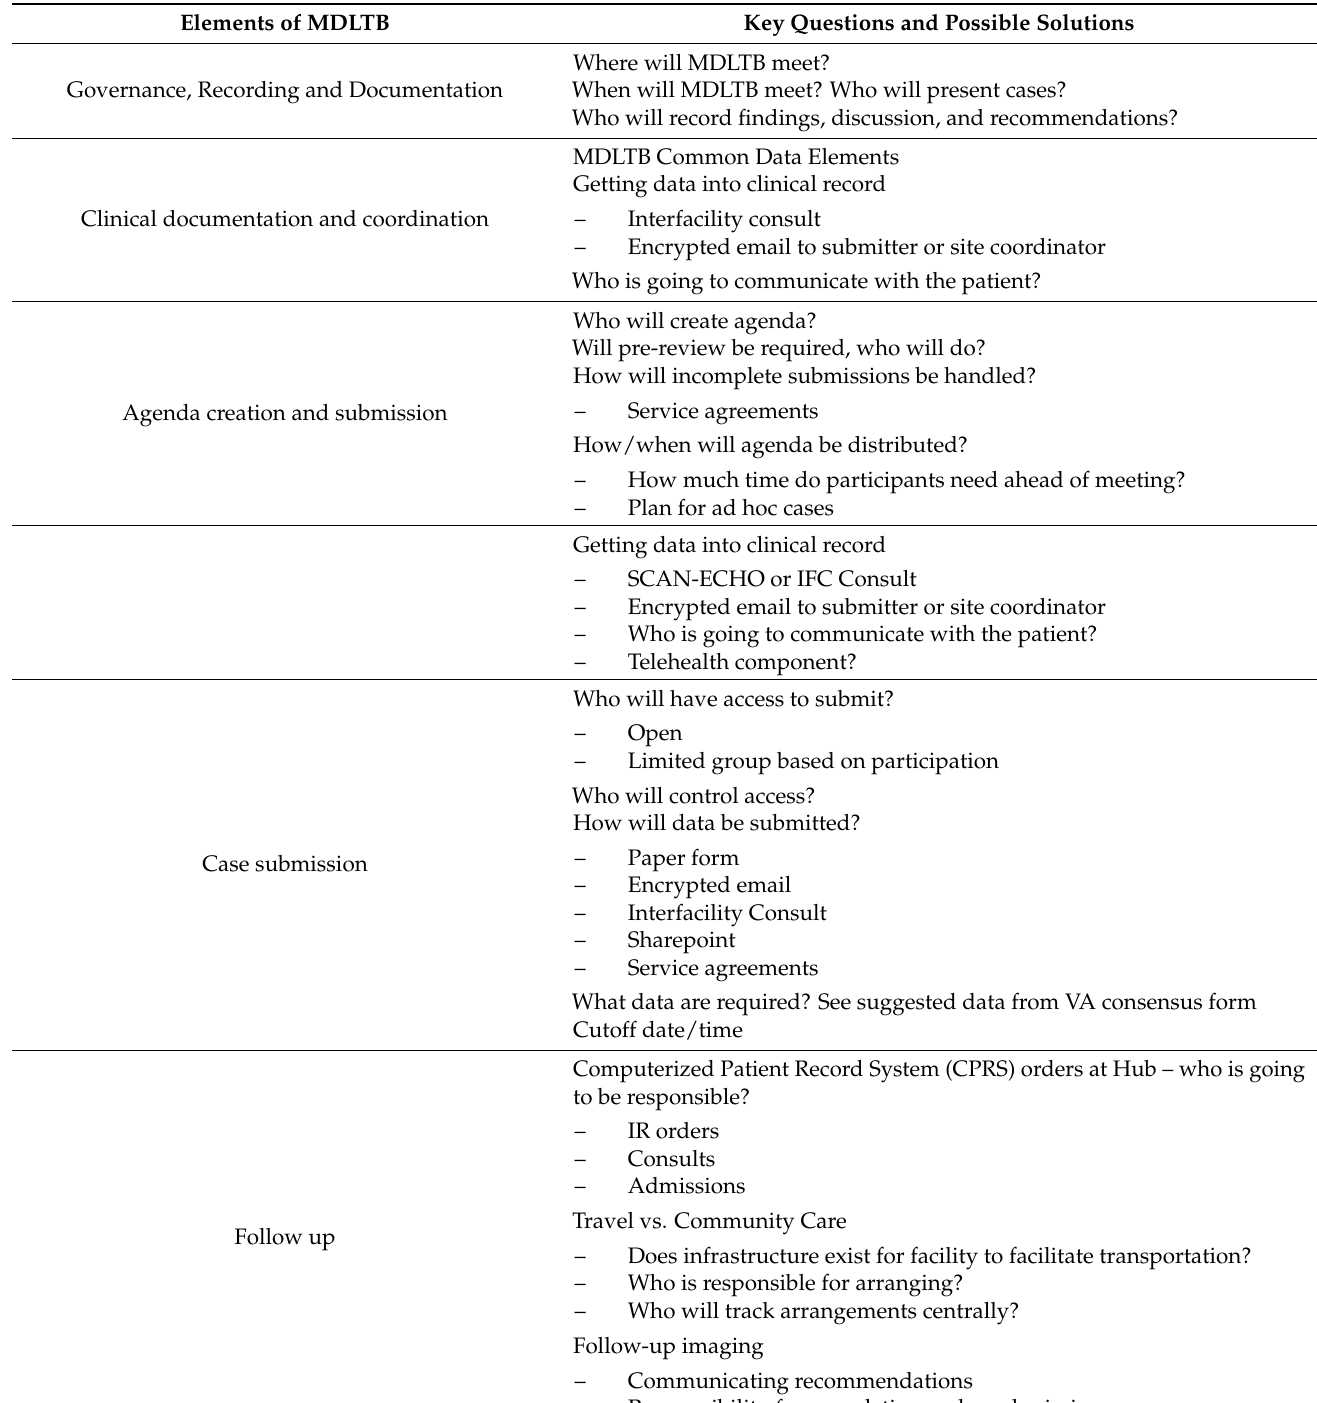
Table 1. Checklist of steps for development of